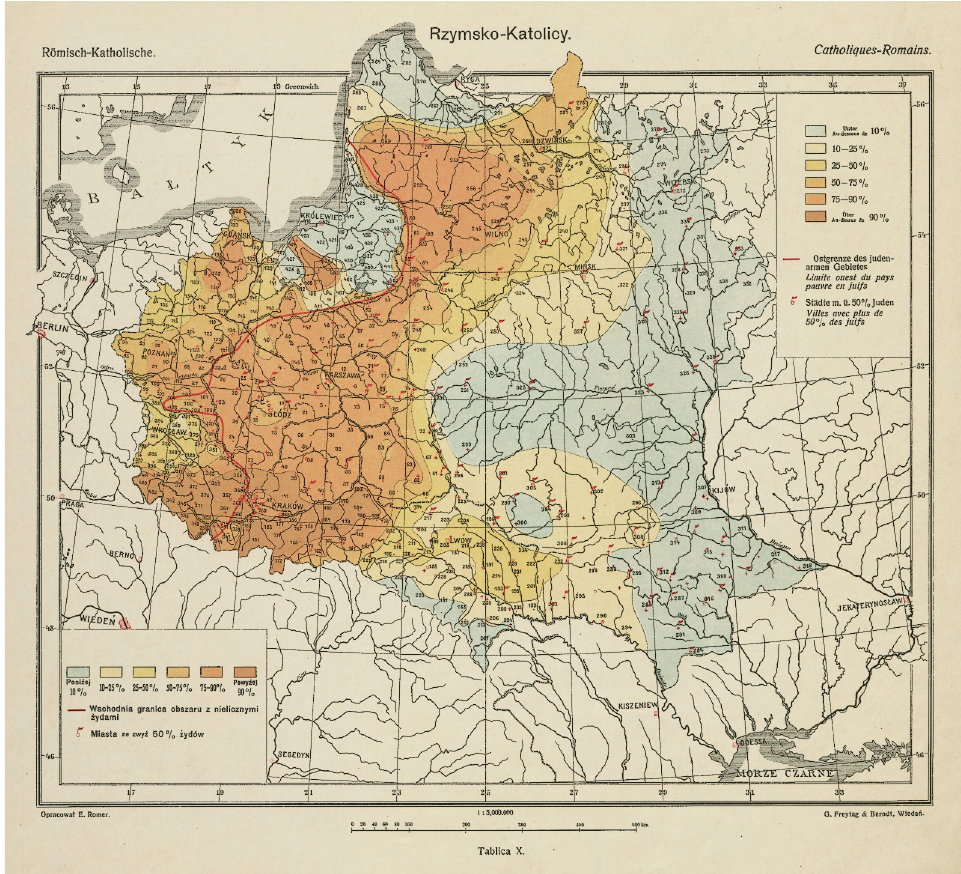
Fig. 4. Table X. Rzymsko-Katolicy (Roman